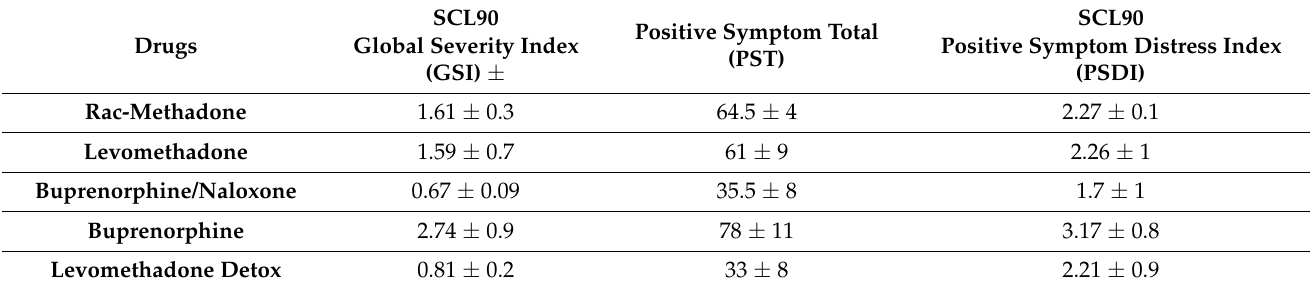
Figure 6. ( A ) Patients distribution with psychiatric comorbidities. ( B ) Drug treatment of patients with double diagnosis (D.D.). ( C ) Urinary positivity of patients with double diagnosis (D.D.) in treatments. Table 9. Psychological indicators of disease. SCL90 = Symptom Checklist-90, a questionnaire used to assess psychological problems of 90